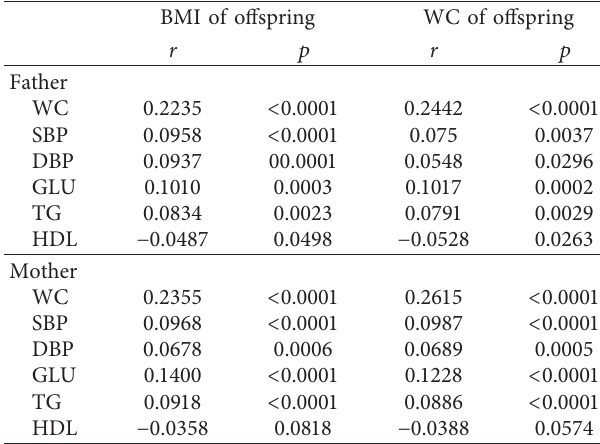
Table 2: Correlations of parental metabolic risk factors with BMI and WC in 12- to 18-year-old adolescents.